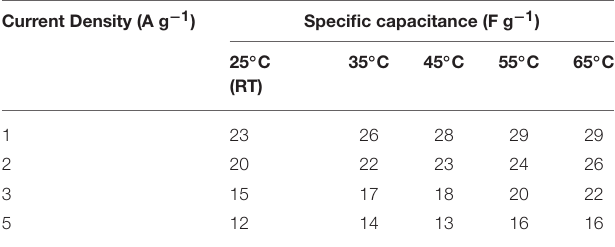
TABLE 3 | Values of specific capacitance at different scan rates at different temperature (screw cell device).